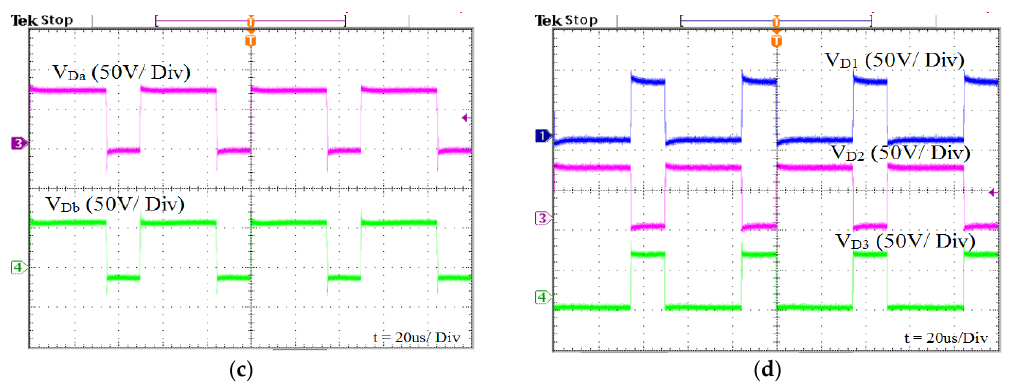
Figure 11. Experimental results when V i = 25 V and D = 0.65. From top to bottom: ( a ) input current and output voltage; ( b ) drain-source current and voltage of switch S 0 ; and ( c , d ) all diodes’ voltage.